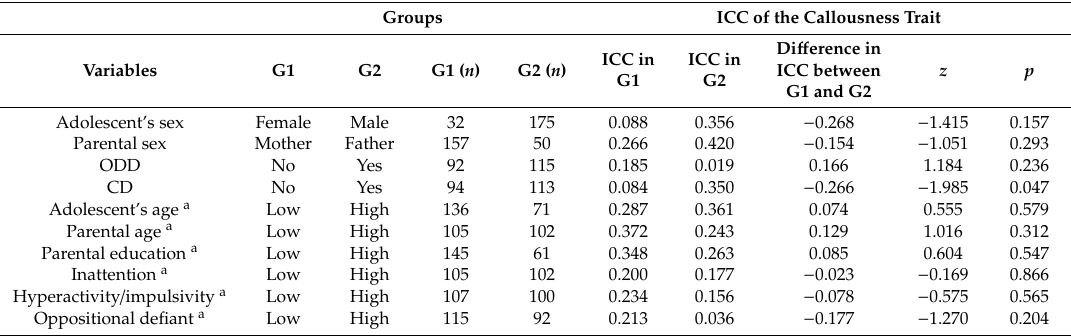
Table 3. Di ff erences in the agreement of adolescent–parent ratings on the callousness trait in various groups of adolescents with ADHD.